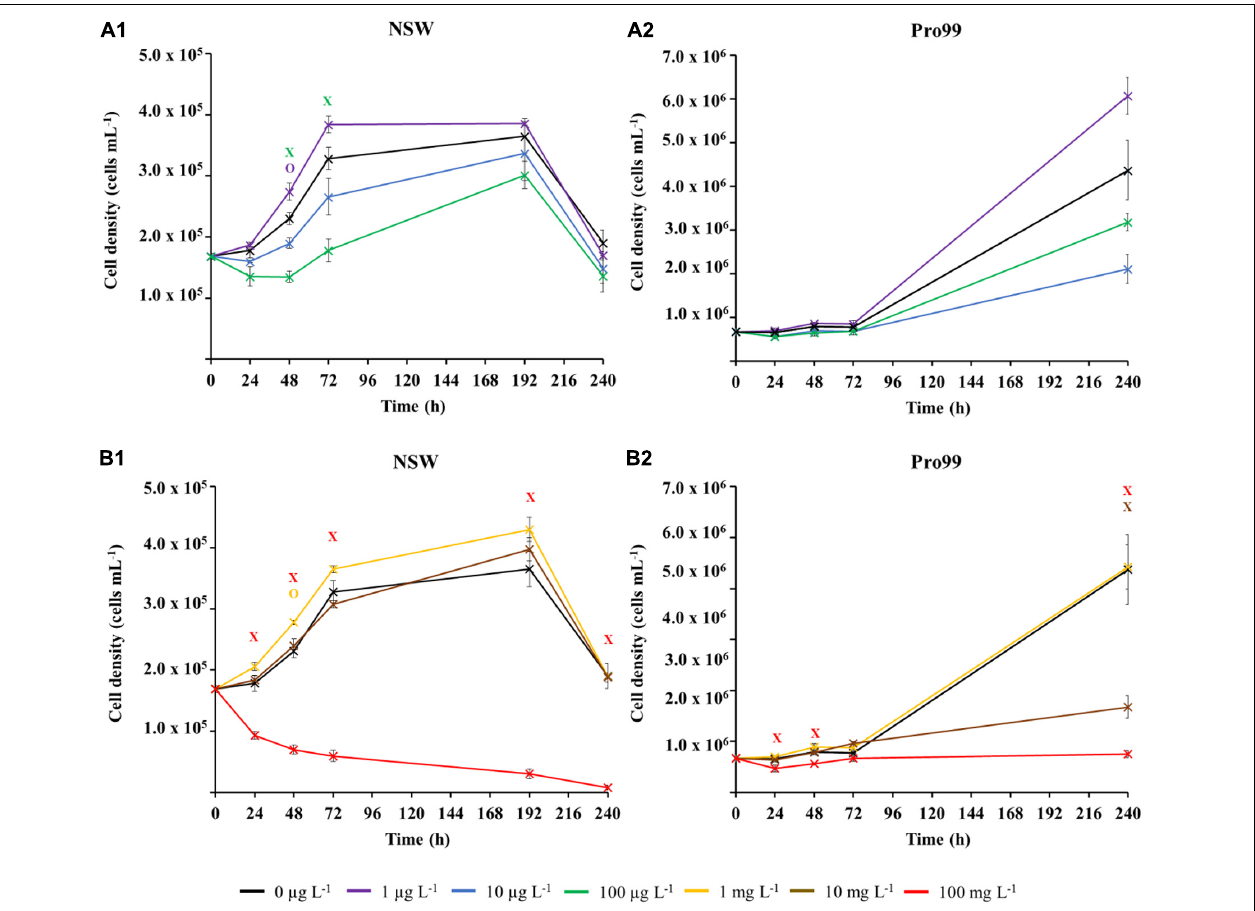
FIGURE 3 | Extended exposure (240 h) of Prochlorococcus sp. MED4 to nCeO 2 in the µ g L − 1 (A) and mg L − 1 (B) concentration range, when exposed in natural oligotrophic seawater (A1,B1) or Pro99 media (A2,B2) . Data is presented as the mean of three culture replicates ± standard error ( n = 3). Dunnett’s T -tests were used to identify significant variations in cell density between nCeO 2 -treated cultures and the untreated control at each timepoint ( p ≤ 0.05); Crosses indicate where cell density was significantly lowered in the nCeO 2 treatment; Circles represent where a significant increase in cell density was